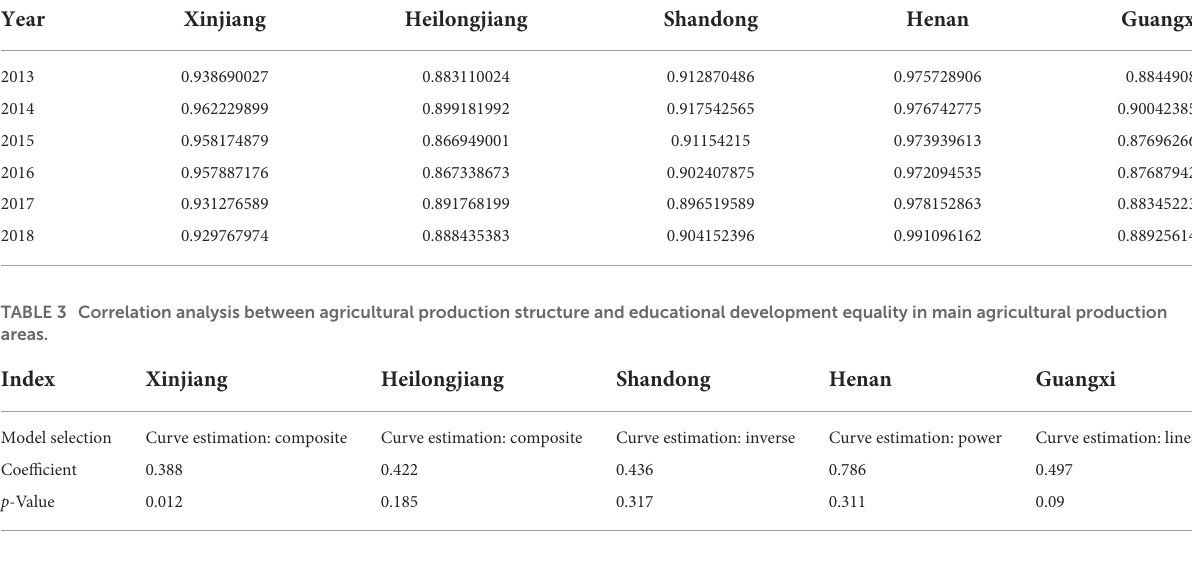
TABLE 2 Rationalization index of agricultural production structure in major agricultural producing areas of China since 2013.